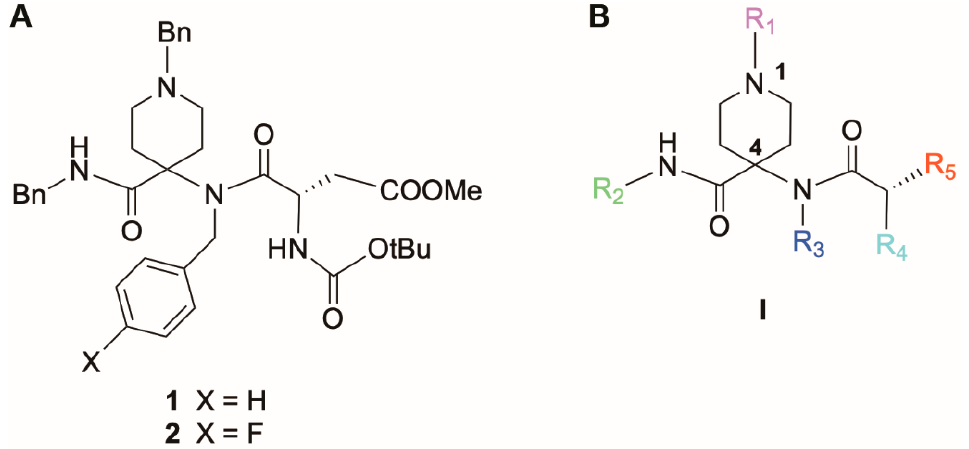
Figure 1. ( A ) chemical structure of compounds 1 and 2 , the two N -benzyl 4,4-disubstituted piperidines which we previously identified as inhibitors of influenza virus membrane fusion [10]. ( B ) general structure ( I ) of the library of 1,4,4-trisubstituted piperidine compounds that we synthesized in the present work to explore the SAR for anti-CoV activity.